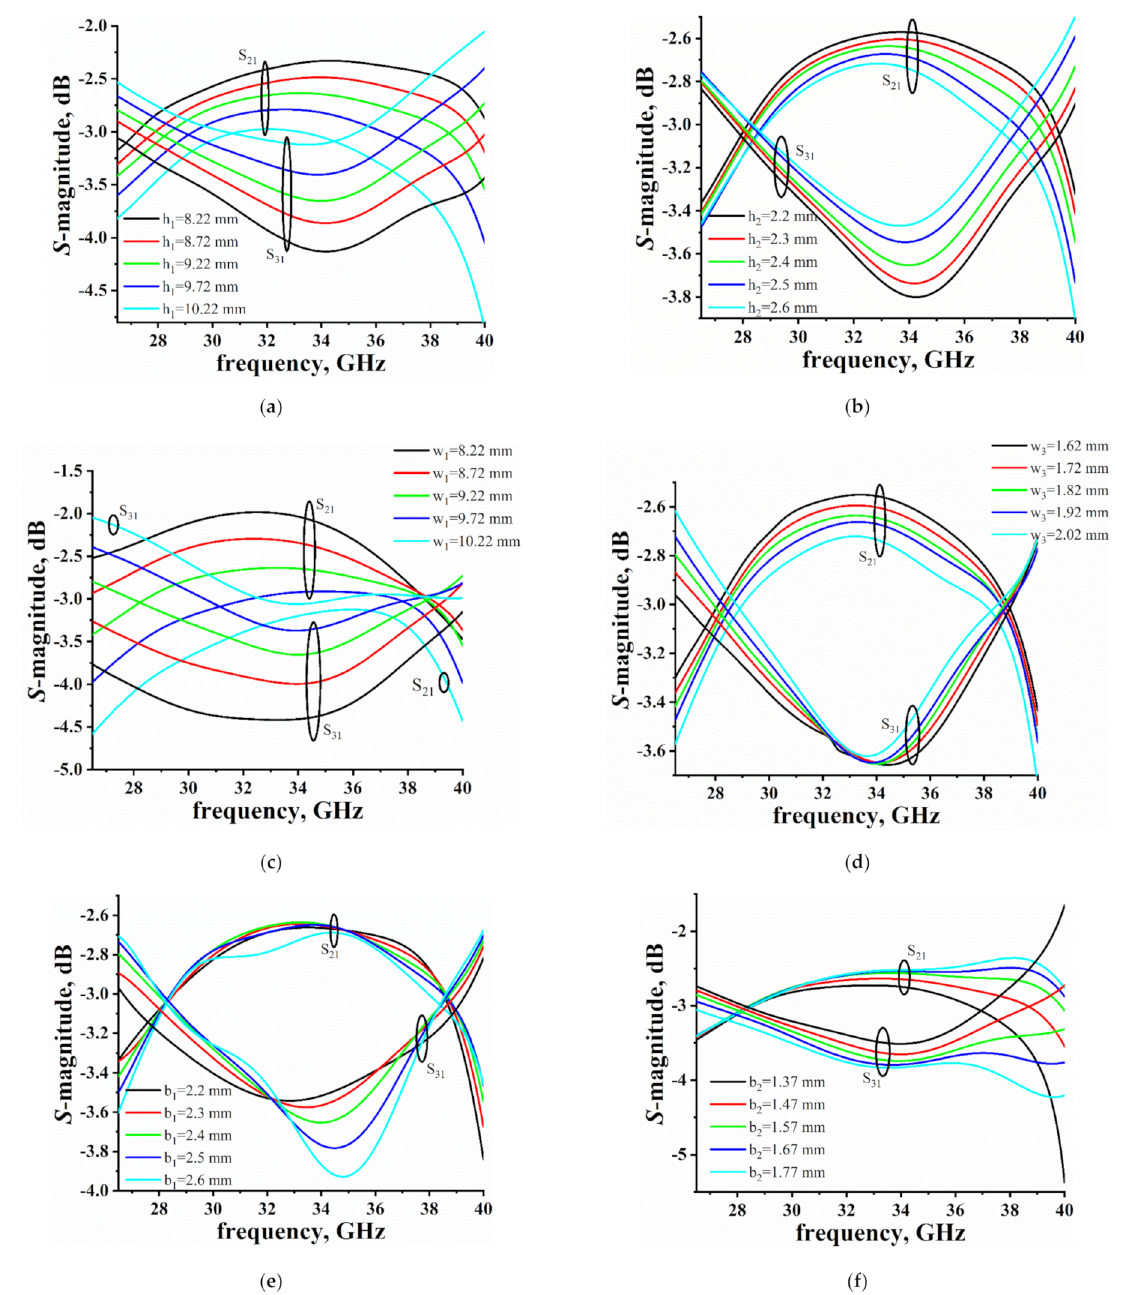
Figure 3. Simulated S 21 and S 31 magnitudes of the proposed coupler with: ( a ) varied h 1 where the other dimensions are fixed as a = 7.12, b = 3.556, r = 0.5, t = 0.5, b 1 = 0.71, b 2 = 1.47, w 1 = 9.22, w 3 = 1.82, h 2 = 2.4, and w 2 = 3.3; ( b ) varied h 2 where the other dimensions are fixed as a = 7.12, b = 3.556, r = 0.5, t = 0.5, b 1 = 0.71, b 2 = 1.47, w 1 = 9.22, h 1 = 3.03, w 3 = 1.82, and w 2 = 3.3; ( c ) varied w 1 where the other dimensions are fixed as a = 7.12, b = 3.556, r = 0.5, t = 0.5, b 1 = 0.71, b 2 = 1.47, h 1 = 3.03, w 3 = 1.82, h 2 = 2.4, and w 2 = 3.3; ( d ) varied w 3 where the other dimensions are fixed as a = 7.12, b = 3.556, r = 0.5, t = 0.5, b 1 = 0.71, b 2 = 1.47, w 1 = 9.22, h 1 = 3.03, h 2 = 2.4, and w 2 = 3.3; ( e ) varied b 1 where the other dimensions are fixed as a = 7.12, b = 3.556, r = 0.5, t = 0.5, b 2 = 1.47, w 1 = 9.22, h 1 = 3.03, w 3 = 1.82, h 2 = 2.4, and w 2 = 3.3; ( f ) varied b 2 where the other dimensions are fixed as a = 7.12, b = 3.556, r = 0.5, t = 0.5, b 1 = 0.71, w 1 = 9.22, h 1 = 3.03, w 3 = 1.82, h 2 = 2.4,